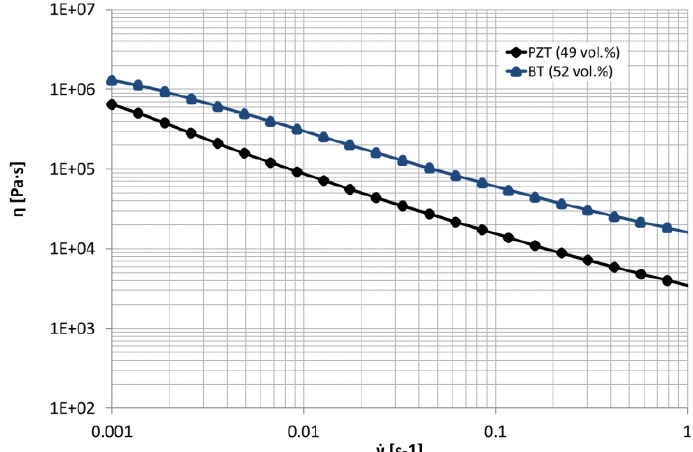
Figure 3. Rheological behavior of two feedstocks, PZT and BT, analyzed with plate-plate rotation rheometer at 150 °C.